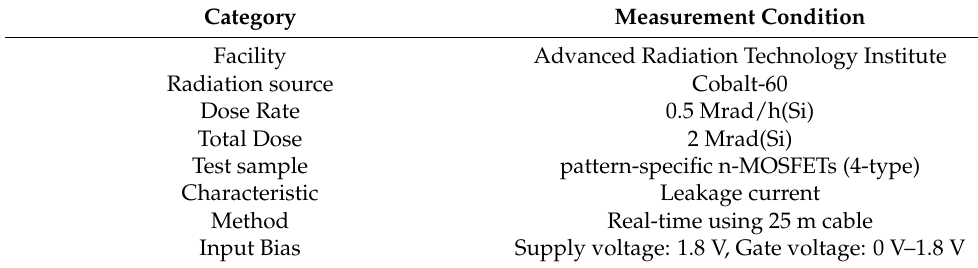
Table 1 . Radiation test conditions for semiconductor devices.